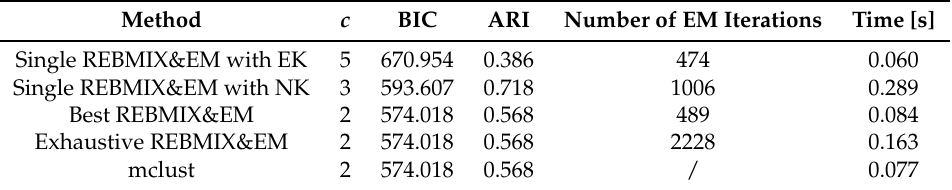
Table 6. Results from the Iris dataset